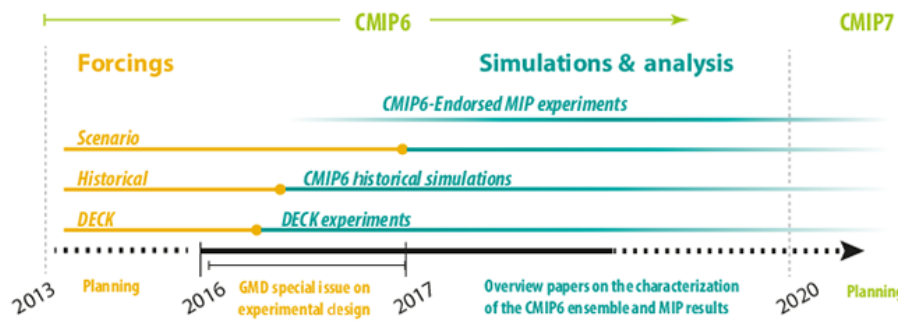
Figure 4. CMIP6 timeline for the preparation of forcings, the realization of experiments and their